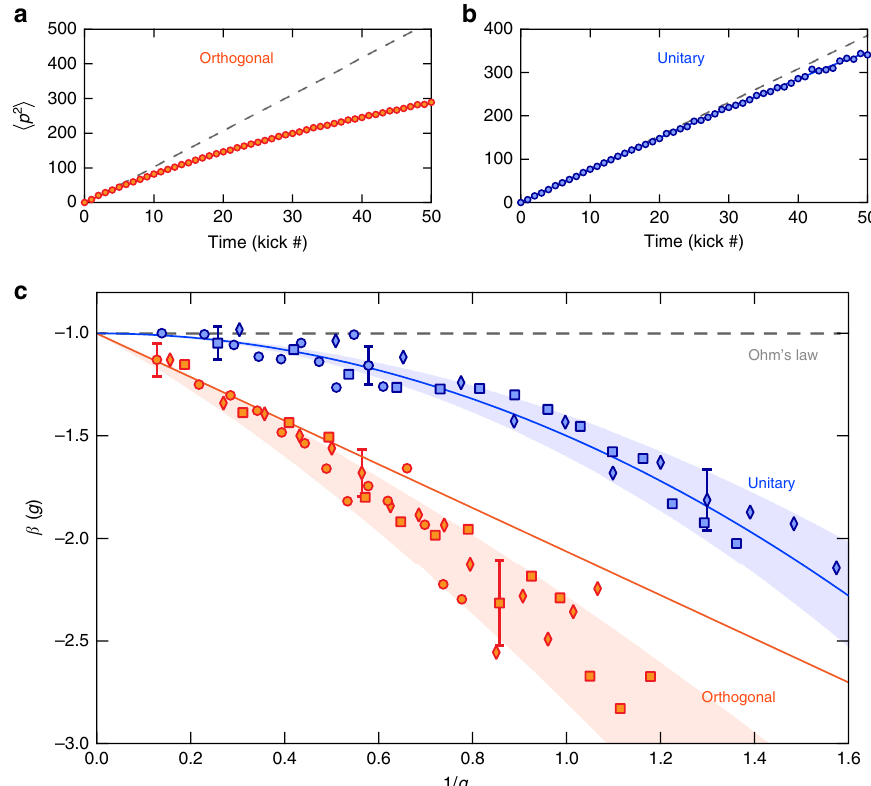
(cid:13) (cid:14) in the weak-localization regime in the two 1 ffiffiffiffiffiffiffiffiffi (cid:13) (cid:14)q = ð (cid:2) h p 2 (cid:13) (cid:14) e t Þ , measured following the 1D spreading of a 1 . The different 1